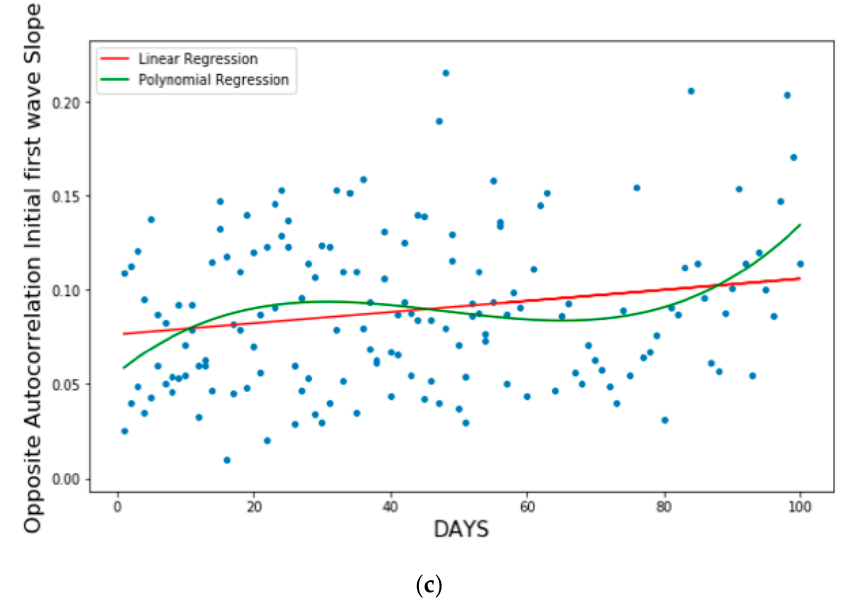
Figure 1. Linear (in red) and parabolic or cubic (in green) regression plots of the opposite of the initial autocorrelation slope vs. ( a ) first wave exponential regression slope for all countries, ( b ) second wave exponential regression slope for developed countries and ( c ) days from the start of the first wave observed in China for all countries. ( a ): LinregressResult slope = − 0.193, intercept = 0.102, r value = − 0.394, p value = 1.026 × 10 − 7 , stderr = 0.03467, p value = 0.00145, stderr = 0.54339, R-squared for order two polynomial regression = 0.19, RMSE for linear regression = 0.0385, RMSE for polynomial regression = 0.046, ( b ): LinregressResult slope = 1.867, intercept = 0.089, r value = 0.487, R-squared for order two polynomial regression = 0.37, RMSE for linear regression = 0.063, RMSE for polynomial regression = 0.094, ( c ): LinregressResult slope = 0.000295, intercept = 0.0765, r value = 0.195469, p value = 0.01415, stderr = 0.000119, R-squared linear regression = 0.038, R-squared for order three polynomial pegression = 0.1, RMSE for linear regression = 0.04, RMSE for polynomial regression = 0.0414825.